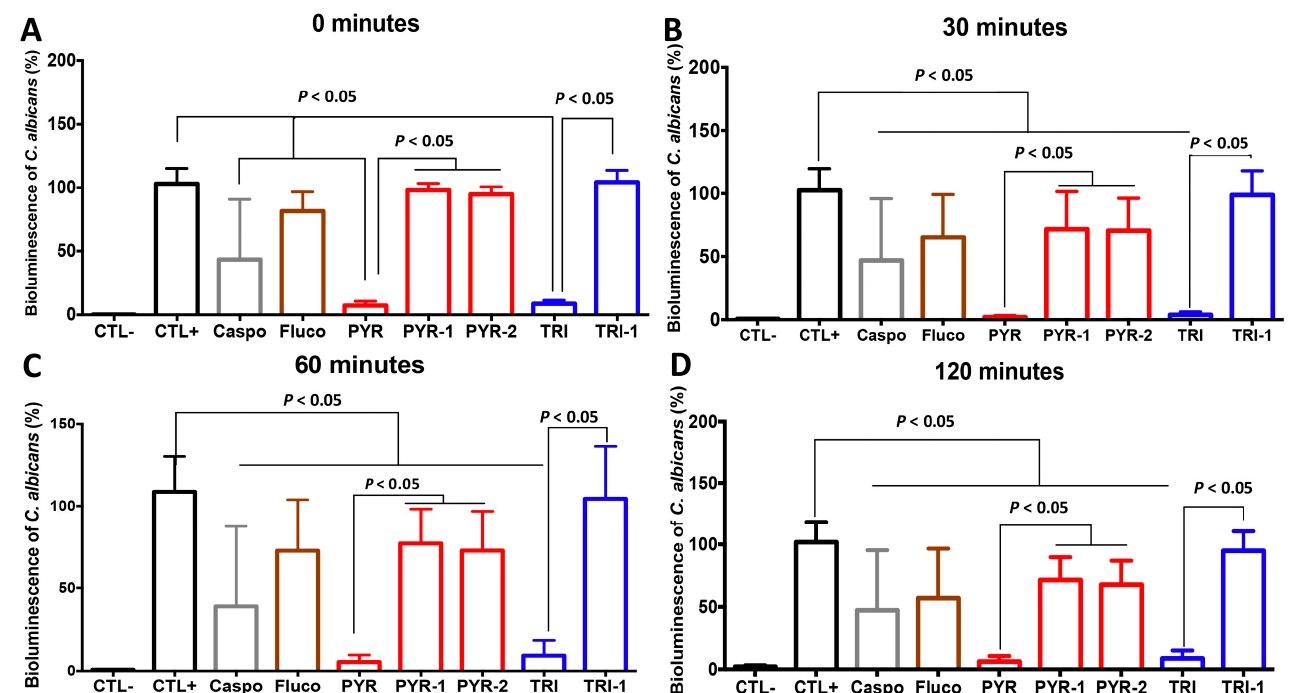
Figure 3. Impact of PYR and TRI and their derivatives on C. albicans viability. Bioluminescent C. albicans strain was treated with PYR, TRI, and their derivatives (PYR-1, PYR-2, and TRI-1) at their 1x MIC and monitored at ( A ) 0, ( B ) 30, ( C ) 60, and ( D ) 120 min. CTL corresponds to PBS and substrate. CTL+ represents C. albicans challenged with PBS. Caspo corresponds to C. albicans cells challenged with caspofungin (1 × MIC). Fluco represents C. albicans cells challenged with fluconazole (1 × MIC). Error bars indicate standard deviations. Table 2. Antifungal activity of PYR and TRI versus caspofungin and